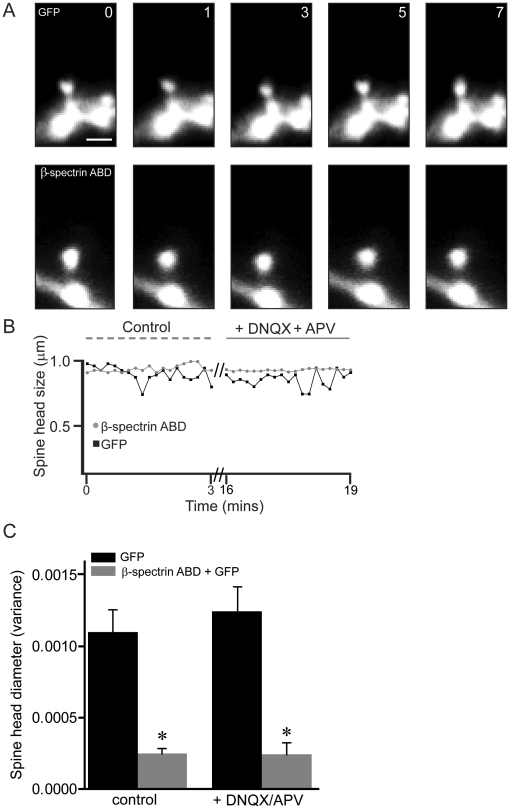
The ABD of βI-spectrin decreases the morphological plasticity of dendritic spines.
A, Time-lapse images in control saline of GFP fluorescence in a single spine from a CA1 pyramidal neuron expressing either GFP alone (upper row) or GFP together with the ABD of βI-spectrin (lower row). Rapid, ongoing changes in the shape of the spine head occurred in spines expressing GFP alone, but not in spines expressing both GFP and the ABD of βI-spectrin. Scale bar = 1 µm; time in sec. B, Changes in spine head diameter in the spines from A were plotted over time. Spines expressing GFP exhibited more spontaneous morphing, compared to A spine expressing the ABD of βI-spectrin, regardless of whether NMDARs and AMPARs were active. C, Group data showing the variance of spine head diameter in neurons expressing GFP alone or the ABD of βI-spectrin in the two conditions. Spines expressing the ABD of βI-spectrin displayed significantly less variance in the shape of their heads than did spines expressing GFP alone (n = 5 neurons/group; * = p<0.001, Kruskal-Wallis test). There was no significant effect of blocking NMDARs and AMPARs on spontaneous morphing in any condition.